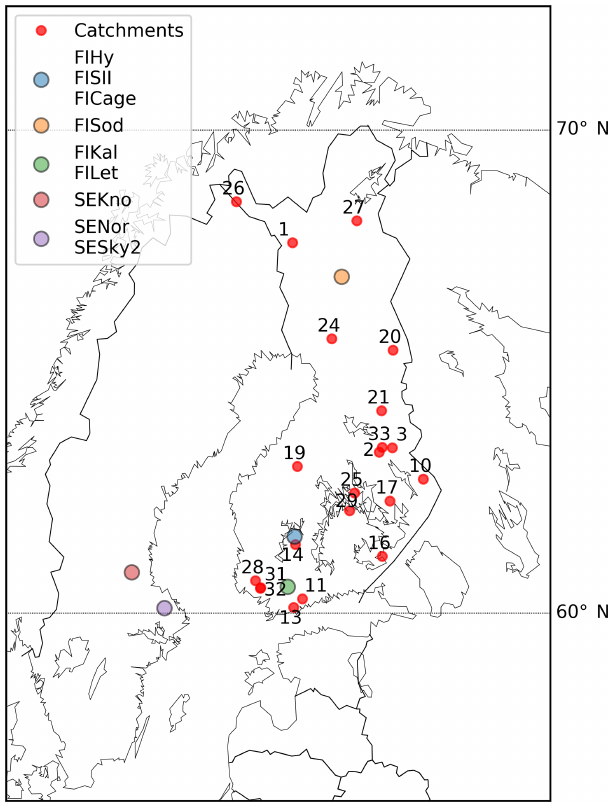
Figure 2. Location of the forest and peatland eddy-covariance sites and the 21 boreal headwater catchments used in the